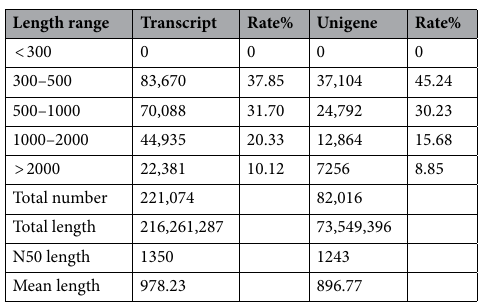
Table 2. Summary of de novo assembly of the A. dissimilis transcriptomes.